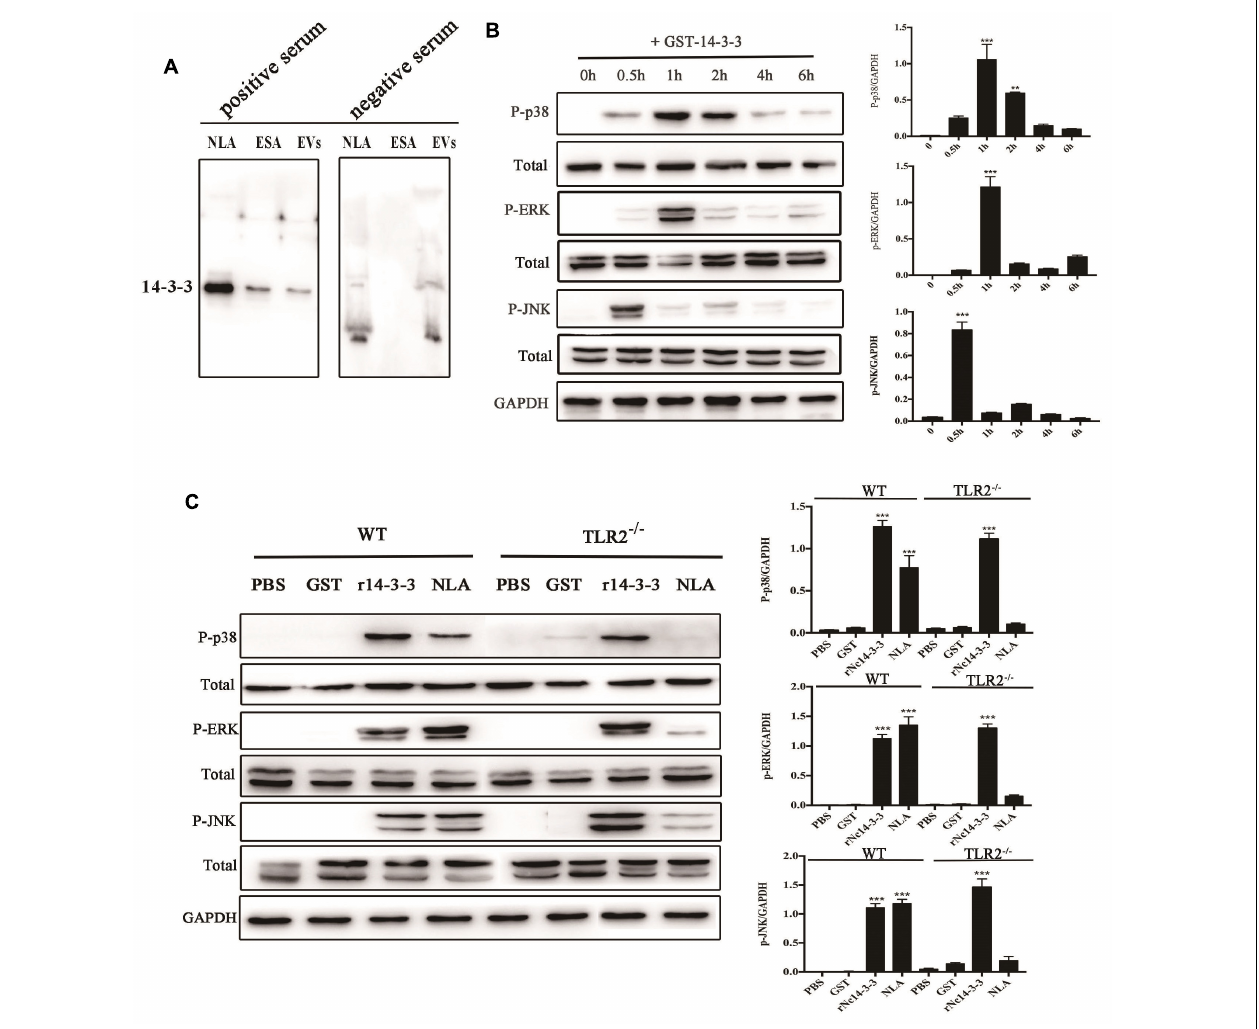
FIGURE 4 | Recombinant Nc14-3-3 activates MAPK signaling pathways in WT and TLR2 − / − mouse PMs. (A) The 14-3-3 protein detected in different N. caninum -derived polypeptides fractions via Western blotting. (B) The phosphorylation levels of p38, ERK, and JNK were determined by Western blotting, the phosphorylation of p38 (at 1 h), ERK (at 1 h), and JNK (at 0.5 h) was clearly observed and the relative gray intensity analysis of the Western blotting. (C) WT and TLR2 − / − mouse PMs were incubated with rNc14-3-3 protein or N. caninum lysate antigen (NLA) for 1 or 0.5 h, and the phosphorylation levels of p38 (1 h), ERK (1 h), and JNK (0.5 h) were determined by immunoblot analysis, and the relative levels of the signals from the western blot in panel. ∗ P < 0.05; ∗∗ P < 0.01; ∗∗∗ P < 0.001 for the rNc14-3-3 group versus the PBS